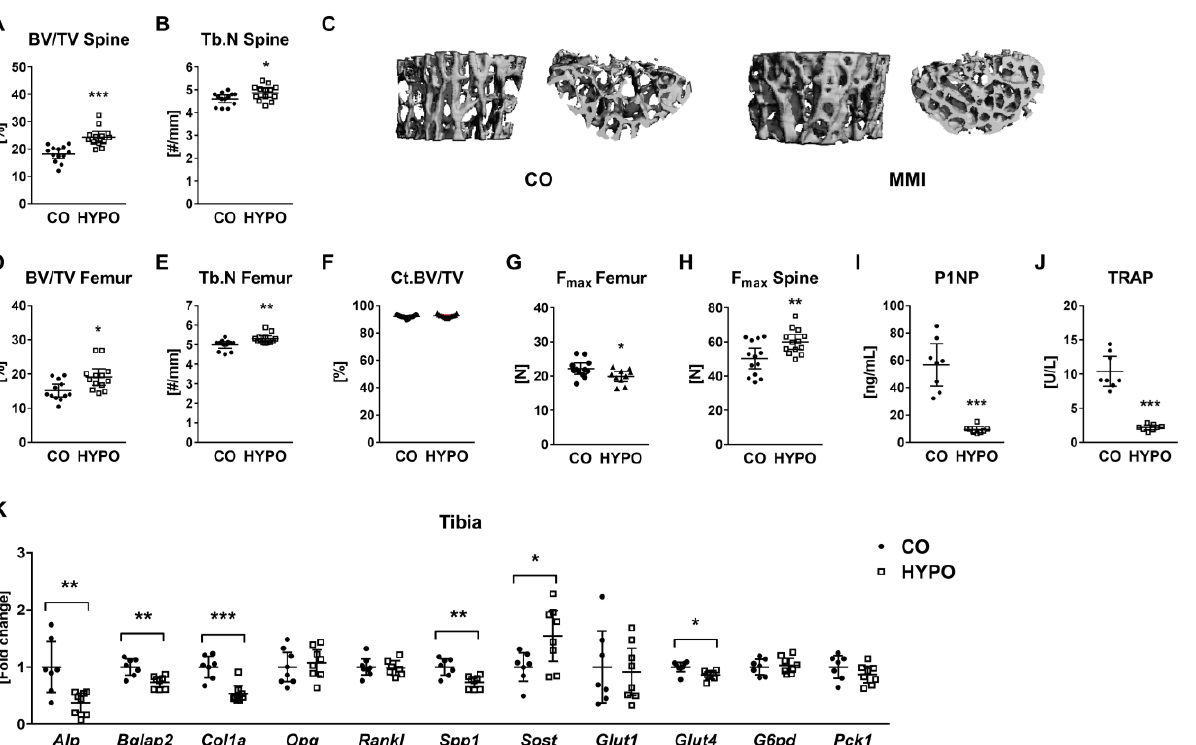
Figure 1. Experimental hypothyroidism leads to trabecular bone gain and reduced bone turnover in male mice. Bones from 16-week-old male hypothyroid (HYPO) and control (CO) mice were examined by microCT. At the spine, ( A ) bone volume/total volume (BV/TV) and ( B ) trabecular number (Tb.N) were determined. ( C ) Representative 3D reconstructions of the trabecular compartment of L4 vertebrae from hypothyroid and control mice. Additionally, ( D ) BV/TV and ( E ) Tb.N were assessed in the distal femur. ( F ) Cortical bone volume/total volume (Ct.BV/TV) was measured at the femoral midshaft. As an indicator of cortical bone strength, ( G ) maximal force (F max ) was determined by 3-point bending test of femurs. ( H ) Vertebral bone strength indicated by F max was determined by a compression test of the L5 vertebra. Furthermore, serum concentrations of ( I ) bone formation marker P1NP and ( J ) bone resorption marker TRAP were measured using ELISAs. ( K ) mRNA expression of Alp , Bglap2 , Col1a , Opg , Rankl , Spp1 , Sost , glucose transporter Glut1 and Glut4 , and G6pd and Pck1 in tibia bone tissue obtained from control and hypothyroid mice was quantified by real-time PCR. Each dot indicates an individual mouse. The horizontal lines represent the mean ± 95% CI. MicroCT analysis: N = 13 per group; biomechanical testing: CO: N = 12, HYPO: N = 10; ELISA: N = 8 per group and real-time PCR: CO: N = 7, HYPO: N = 8. Statistical analysis was performed by Student’s t -test: * p < 0.05; ** p < 0.01; *** p < 0.001 vs.